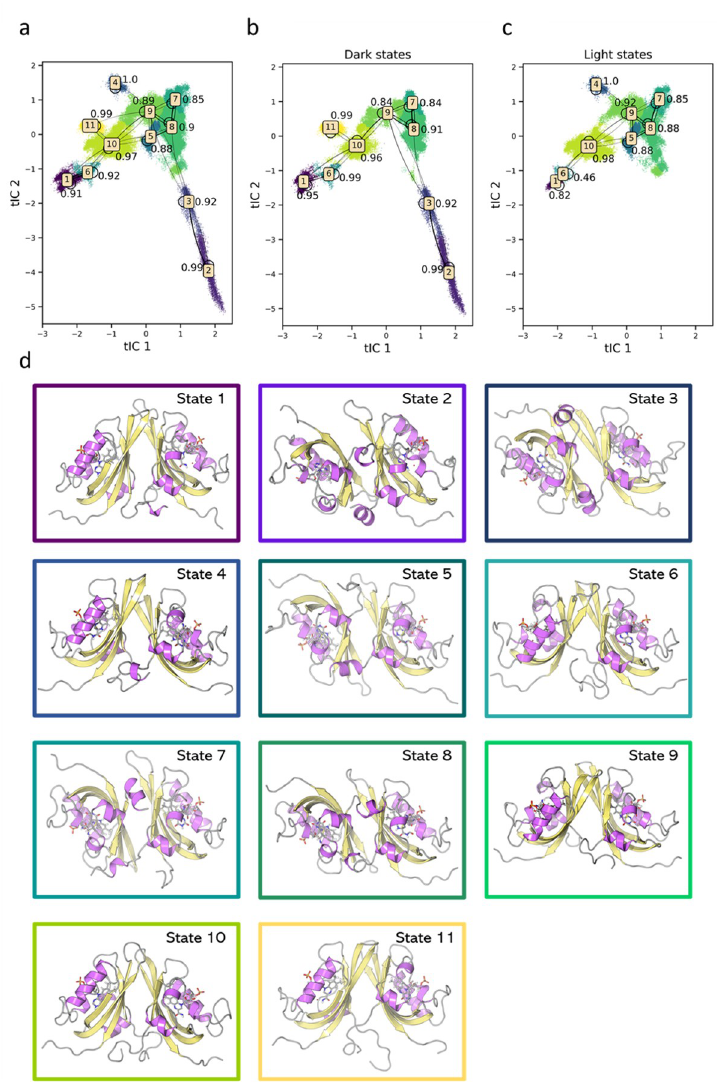
Fig 8. Transition probabilities among different macrostates in the Markov state model. a) Transition probabilities among macrostates using all trajectories; b) Transition probabilities based on Dark state trajectories; c) Transition probabilities based on Light state trajectories; d) Representative structures for different macrostates obtained from each cluster